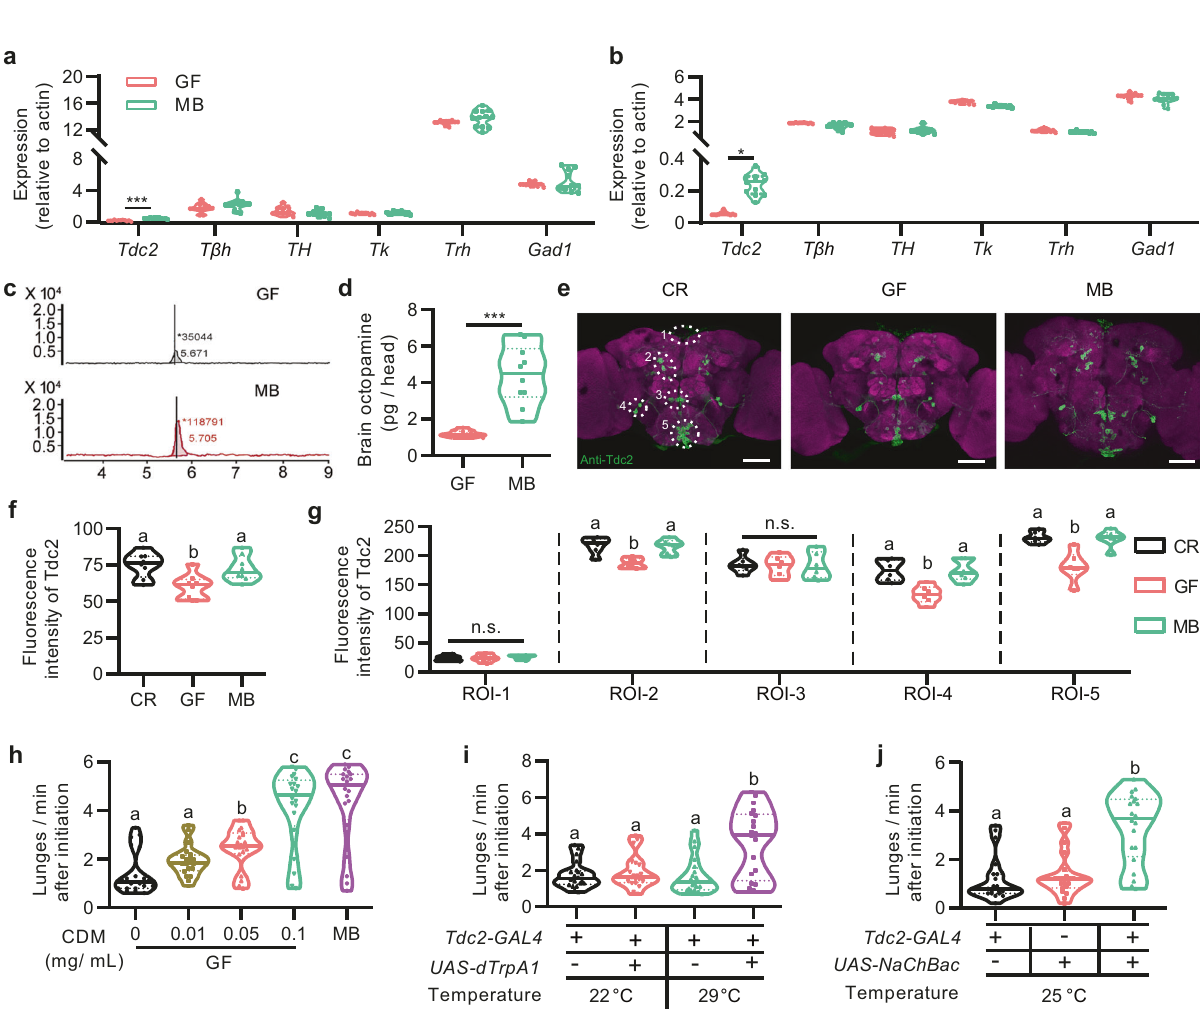
Fig. 4 Gut microbiome promotes aggression through octopamine signaling. a , b Relative expression of Tdc2 , T β H , TH , Tk , Trh , and Gad1 in brains of males ( a ) and females ( b ). n = 12 based on three replicates for each. * p < 0.05, *** p < 0.001, Two-tailed Mann – Whitney U -test. c , d The level of octopamine in GF male brains was signi fi cantly lower than that in MB males. n = 10 for each. *** p < 0.001, Two-tailed Mann – Whitney U -test. e Representative images of the anti-Tdc2 signals in adult brains. Tdc2-expressing neurons were divided into fi ve distinct clusters based on their location. Scale bars, 50 μ m. f , g The average fl uorescence intensity was calculated in total brain region ( f ) and fi ve regions of interest ( g ). n = 8 for each. h OA agonist CDM elevated lunging frequency of GF in a dosage-dependent manner. n = 20 for each. i , j Activating octopaminergic neurons with dTrpA1 ( i ) or NaChBac ( j ) signi fi cantly increased lunging frequency of GF males. n = 20 for each. For all variables have different letters, they are signi fi cantly different ( p < 0.05). Kruskal – Wallis test followed by Dunn ’ s multiple comparisons